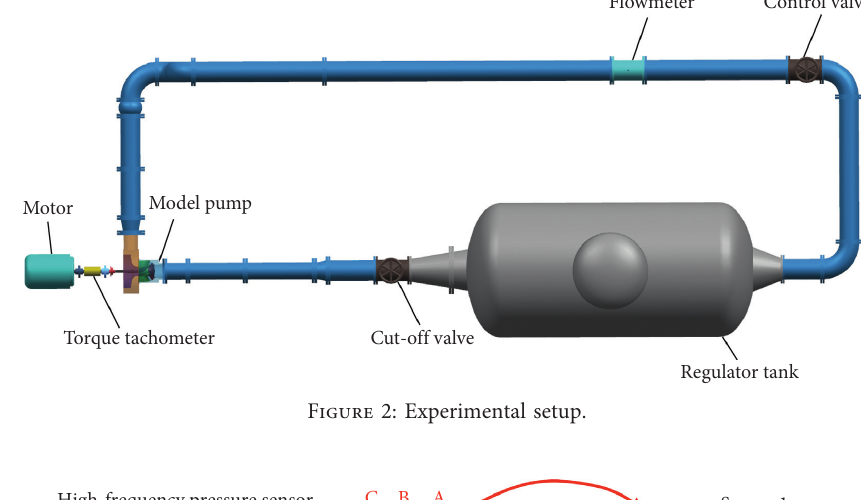
Figure 2: Experimental setup.